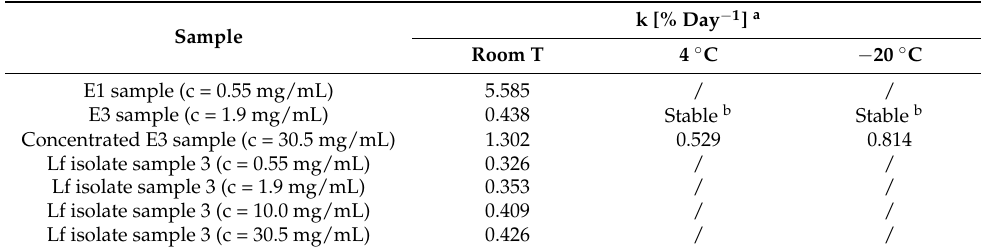
Table 7. Degradation rate constants for various Lf samples at different